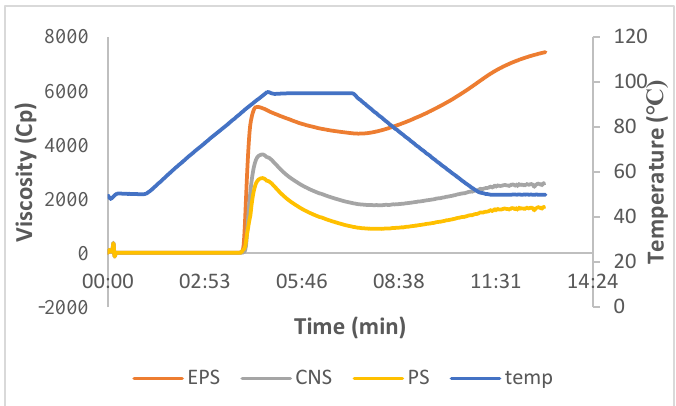
Figure 2. Pasting profile of untreated and CLSs.